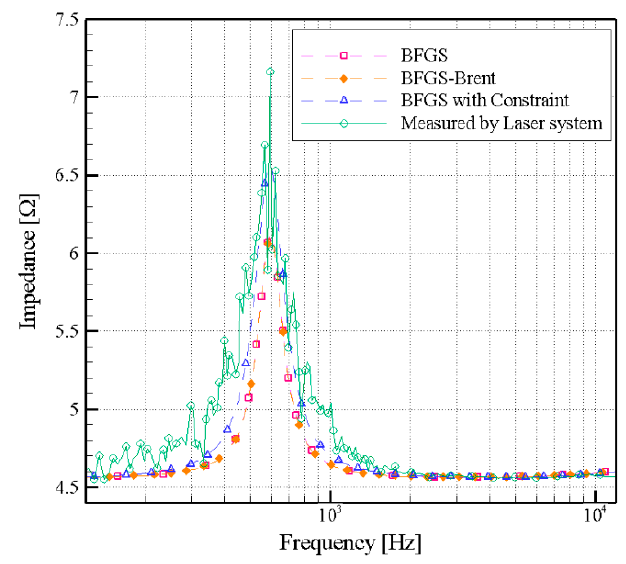
Figure 12. Comparison of impedance curves obtained using different methods and the laser displacement measurement system.